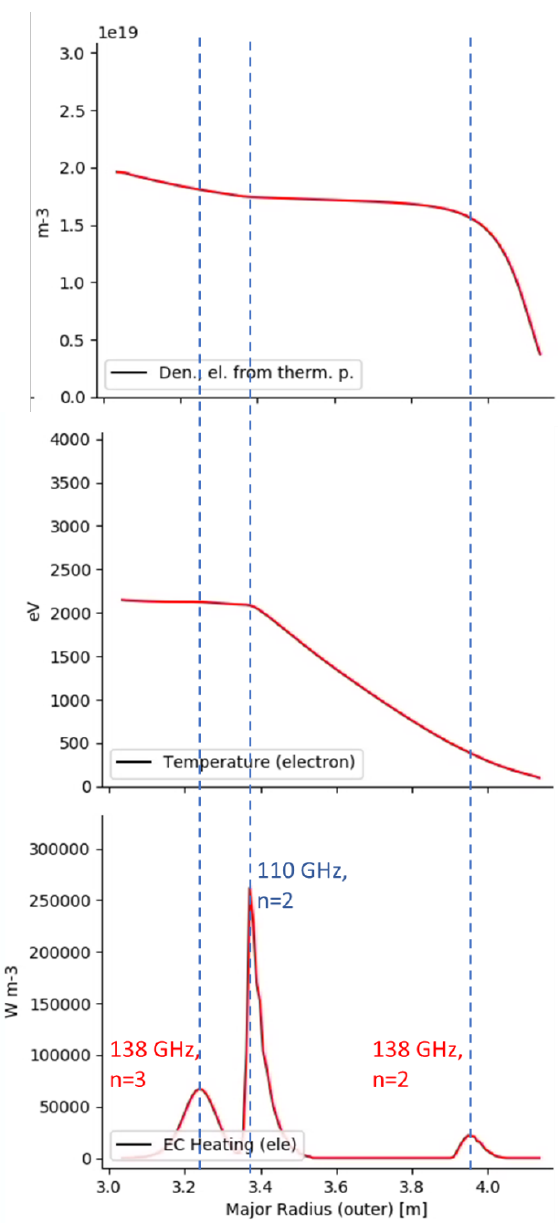
Fig. 9. Density, temperature and absorption profiles for